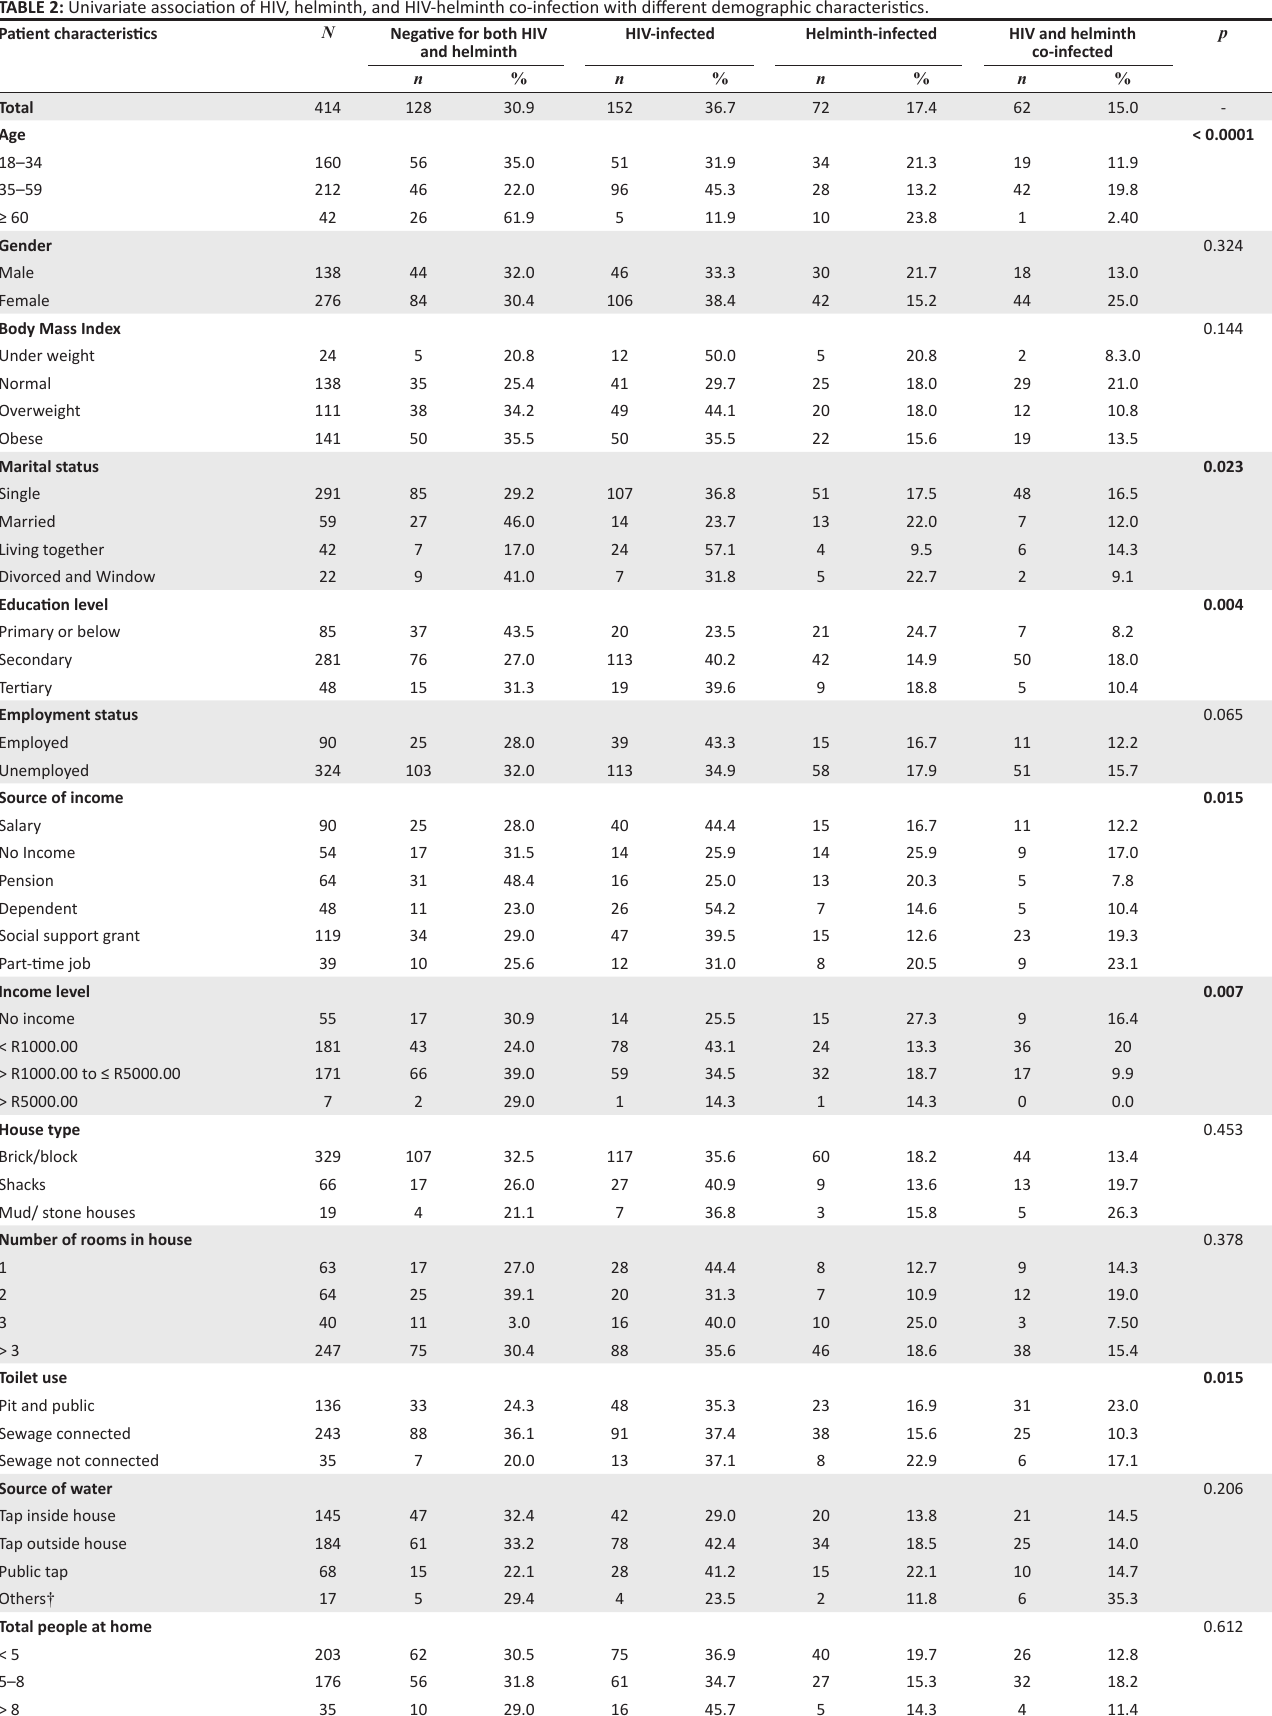
TABLE 2: Univariate association of HIV, helminth, and HIV-helminth co-infection with different demographic characteristics. Patient characteristics